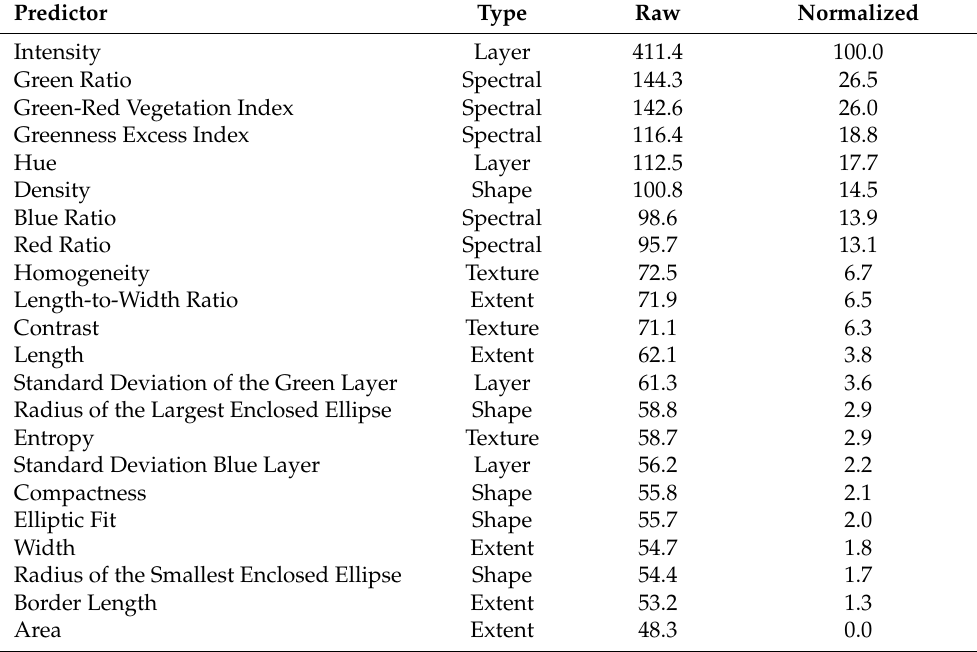
Table 3. Importance values for the features in the optimal random forest model. Importance values were normalized to a value between 0 and